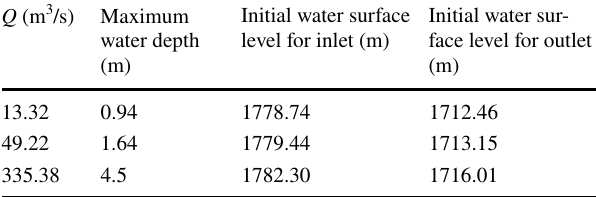
Table 2 Initial water surface level for inlet and outlet of the computa- tional mesh according to discharges and maximum water depth